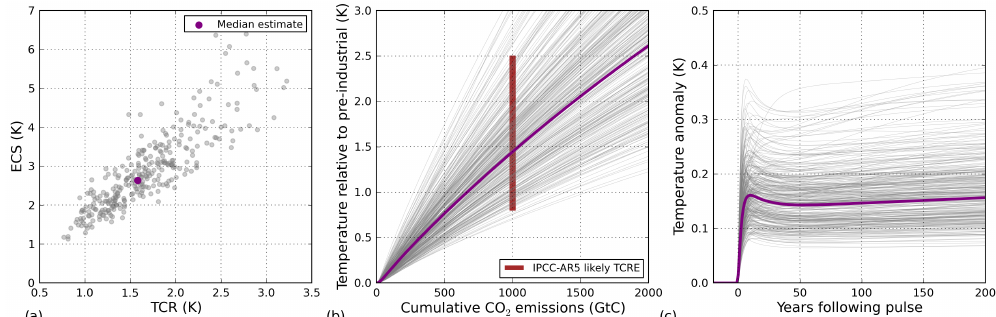
Figure 8. Probabilistic sampling in the FAIR model. Grey lines show 300 random draws from the input parameter distributions, as described in Sect. 3.4. (a) shows the joint distribution of TCR and ECS. (b) shows warming as a function of cumulative emissions in the 1%year − 1 concentration increase experiment. The brown bar in (b) represents the IPCC AR5 likely TCRE range. (c) shows the warming response to a 100GtC pulse emitted in 2020 on top of the MAGICC-derived RCP2.6 emissions. The purple dot (a) and lines (b, c) represent the median parameters of the